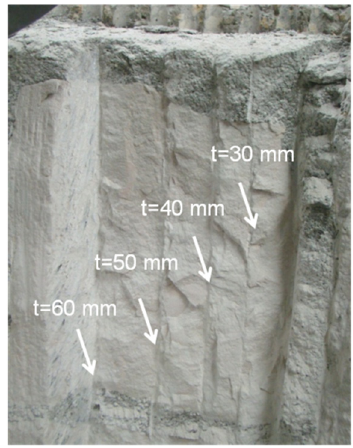
Figure 17. A view of the sandstone block surface after completing the mining tests in the vertical plane [30].